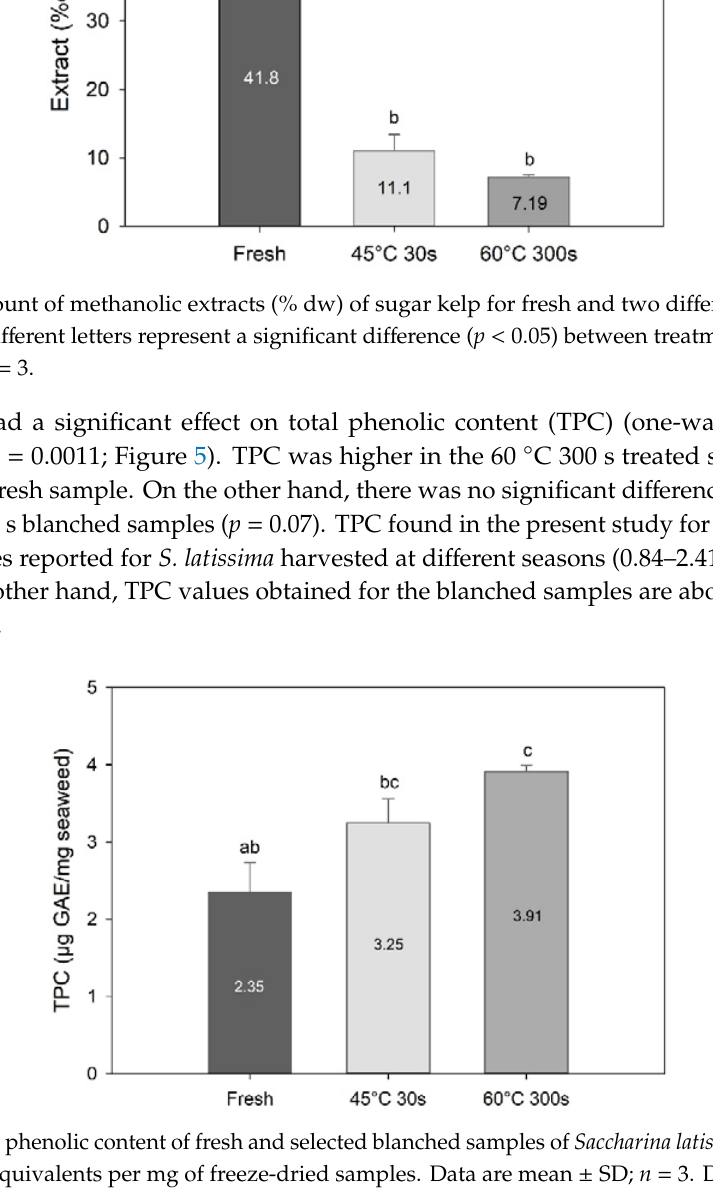
Figure 6. Total phenolic content expressed in gallic acid equivalents per mg of methanolic extract of Saccharina latissima from fresh and two types of blanching. Data are mean ± SD; n = 3. Different letters represent a significant difference ( p ˂ 0.05) between treatments. DPPH radical scavenging activity revealed a concentration dependency and increased with increasing concentrations of algal extract (data not shown). Processing increased the radical scavenging activity significantly (F = 13.5, df = 3, p = 0.0053, Figure 7). These results suggest that compounds with high radical scavenging activity are retained and up ‐ concentrated in the sugar kelp during water blanching. This correlates well with the current results; TPC have been identified as a major component contributing to radical scavenging activity of seaweed [5,35–38].